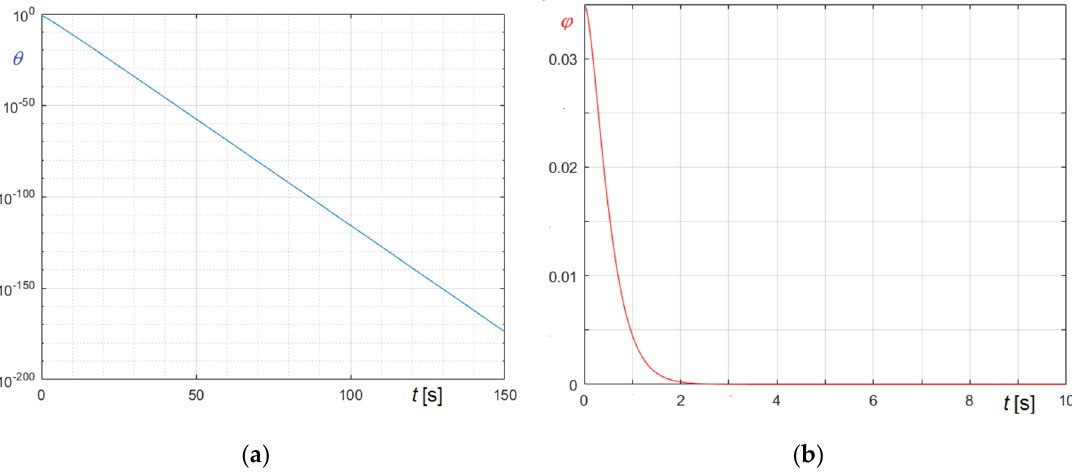
Figure 10. Time − rotation curves of the St. Mary tenor bell in critically damped conditions: ( a ) log θ − t curve of critically damped bell; ( b ) θ − t curve of critically damped